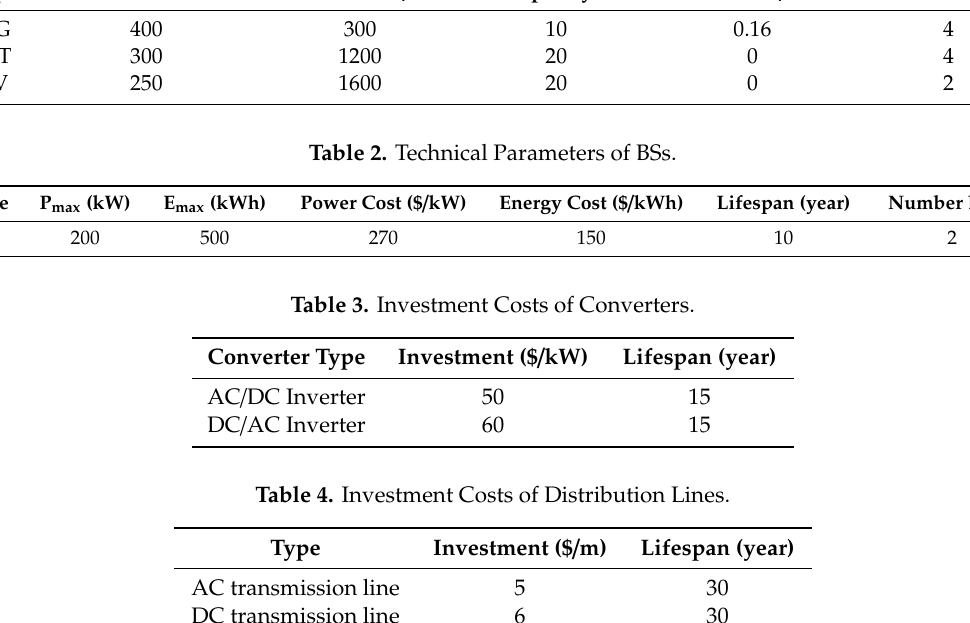
Table 5. Electricity Prices.